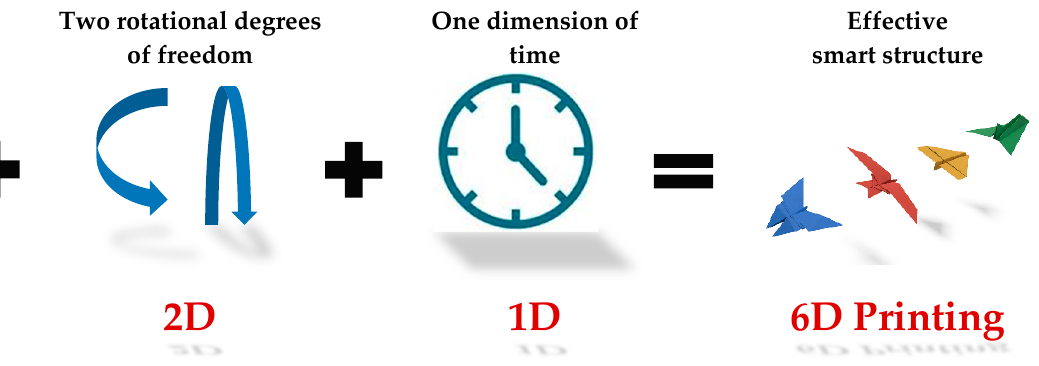
Figure 1. The 6D Printing method: Dimensionality clarification.